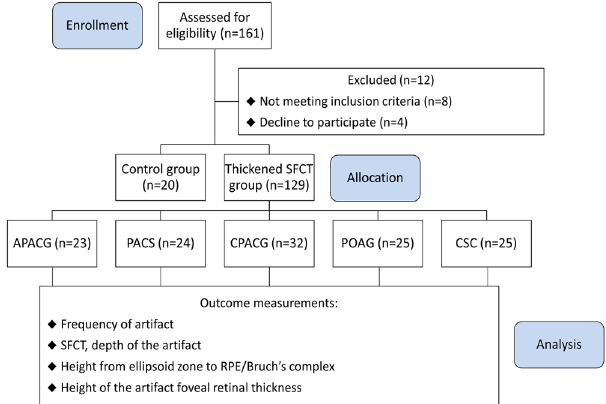
Figure 3. Summary and flow diagram of the study design (n: number of eyes). APACG: acute primary angle closure glaucoma; PACS: primary angle closure suspect; CPACG: chronic primary angle closure glaucoma; POAG: primary open angle glaucoma; CSC: central serous chorioretinopathy; SFCT: subfoveal choroidal